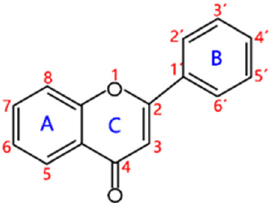
Figure 1. General structure of flavonoids.